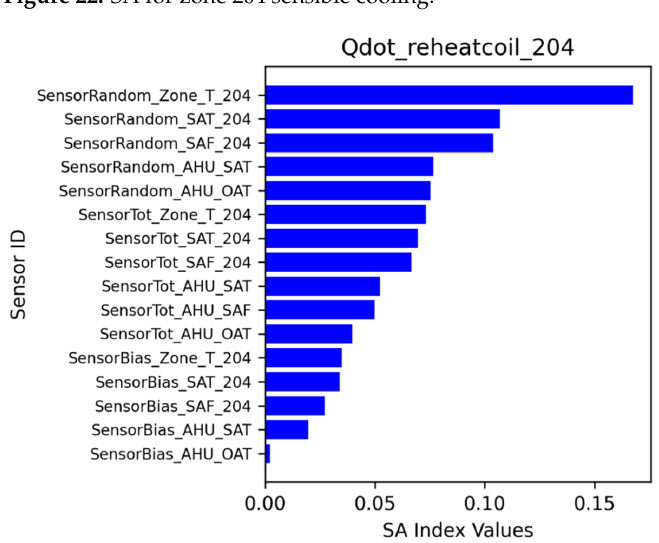
Figure 23. SA for zone 204 reheat coil energy.